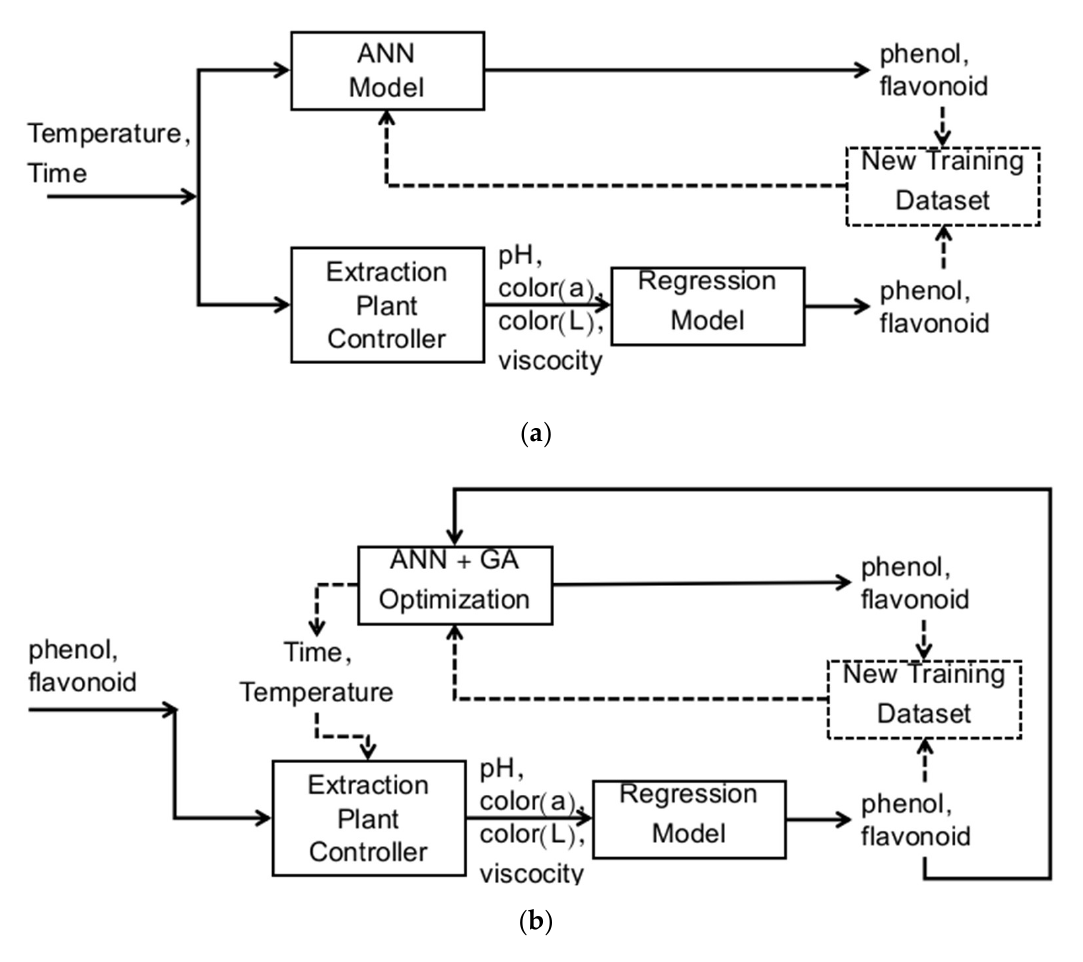
Figure 12. Indirect ( a ) and direct ( b ) neuro-control design.